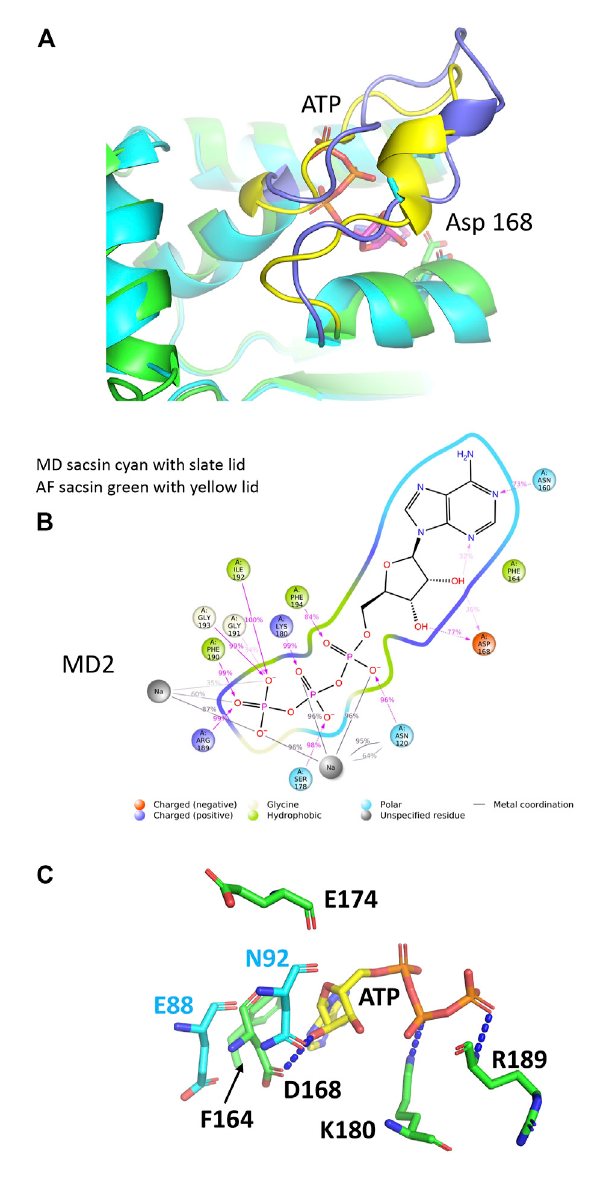
FIGURE 4 Analyses of the molecular dynamic model of sacsin-ATP. (A) Superimposition of the MD model of sacsin-ATP (cyan with slate colouredlid)withthatofAlphaFold(greenwithyellowcolouredlid). (B) A schematic of detailed ligand atom interactions with the protein residues. Interactions that occur more than 15.0% of the simulation time in the entire trajectory, are shown. It is possible to have interactions with > 100% as some residues may have multiple interactions of a single type with the same ligand atom. Pi-cation interactions are shown in red, whilehydrogenbondisshowninpink. (C) PyMolcartoonshowingsacsin residues (green sticks) not conserved with Hsp90 and their interaction with ATP (yellow stick). Hsp90 residues are shown in cyan stick. Sacsin Asp 168 interacts with ATP, but the equivalent position in Hsp90, Glu 88 does not. In contrast, sacsin Glu 174 does not interact with ATP, but the equivalent Hsp90 residue, Asn 92, does